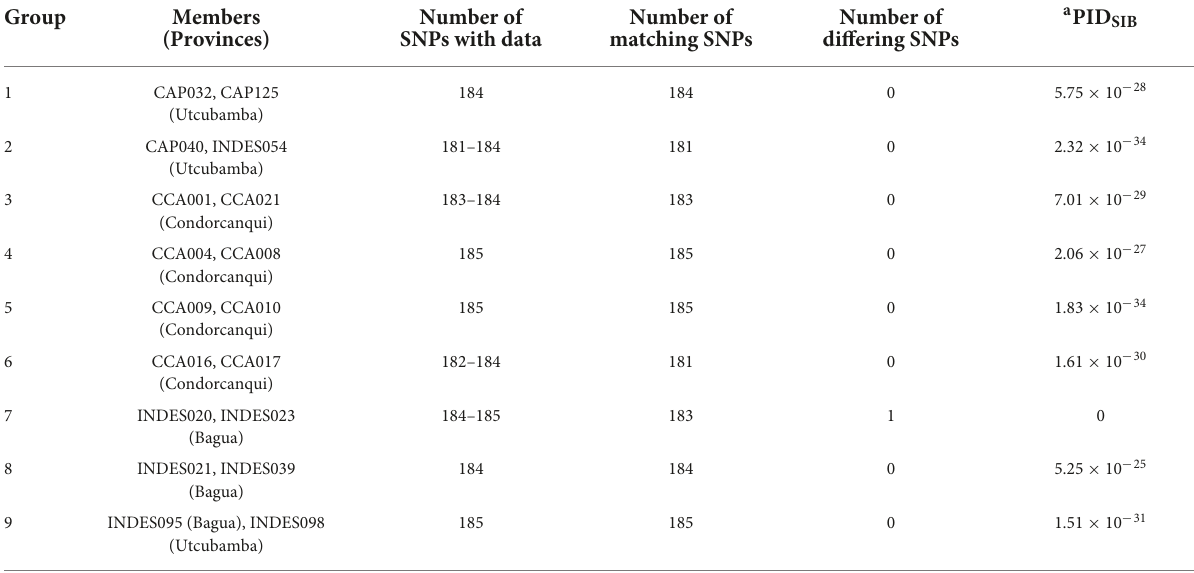
TABLE 1 Groups of matched samples in 143 cacao trees in northern Peru using 185 single nucleotide polymorphism (SNP) markers.